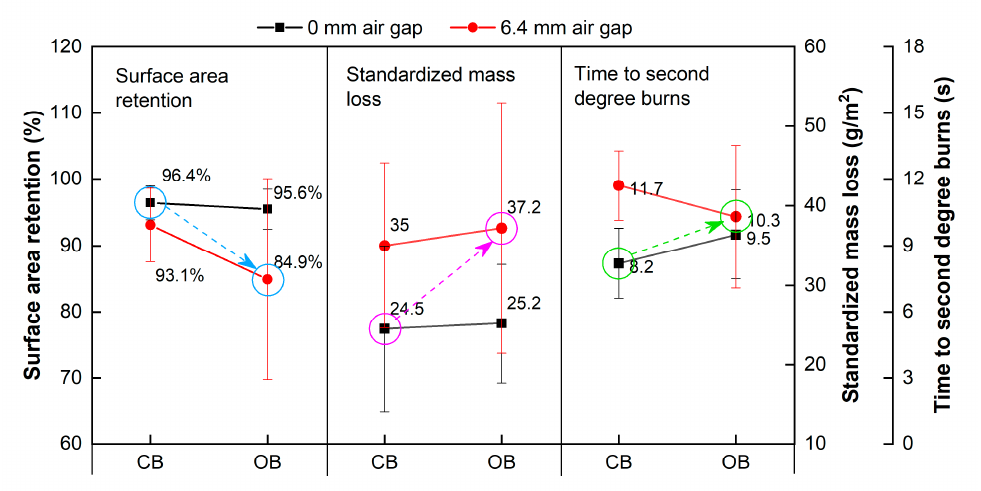
Figure 9. Comparison of the results between confined and open boundary conditions. CB—confined boundary; OB—open boundary.